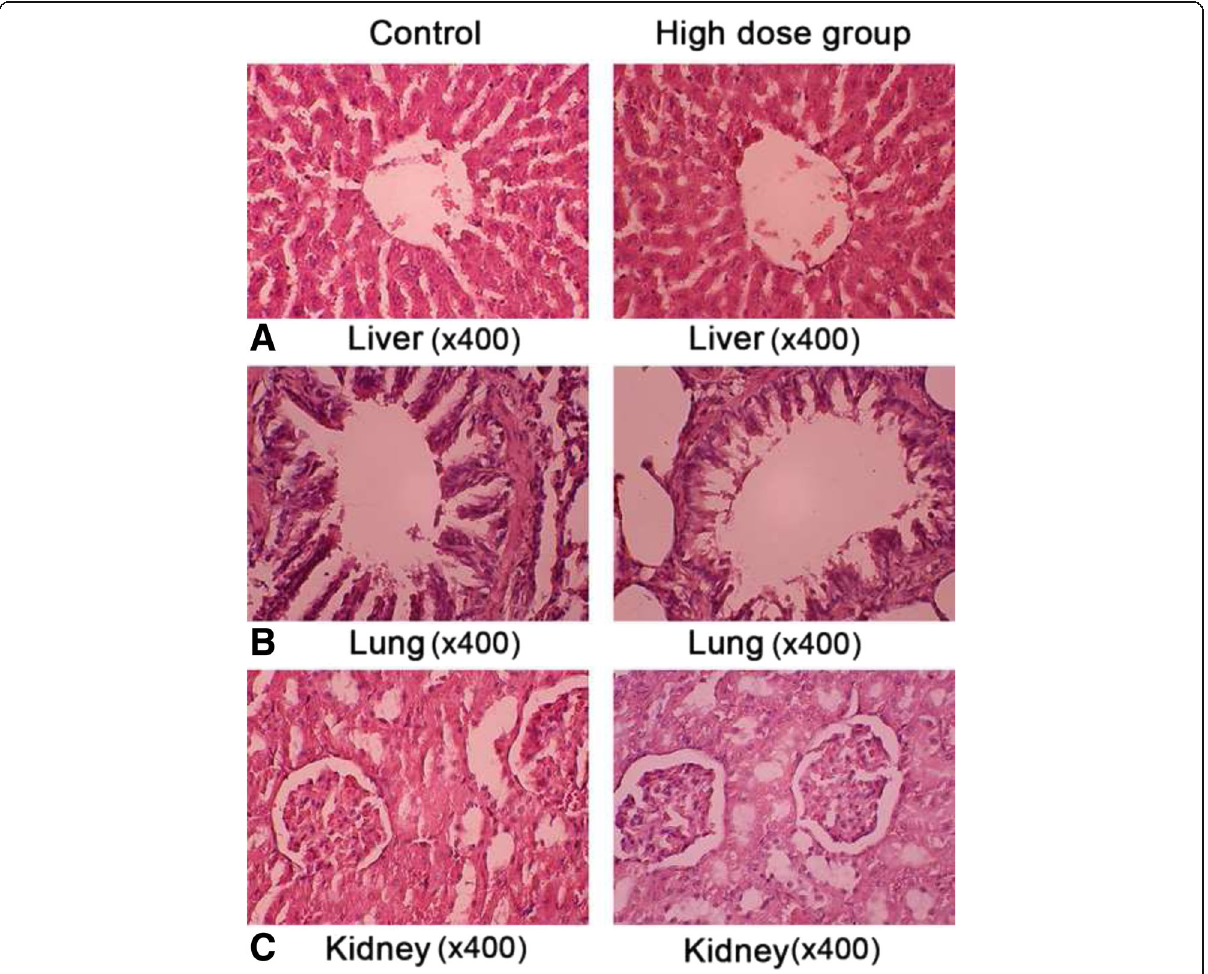
Fig. 2 JDHF treatment maintains normal structure of liver, lung, and kidney. Representative images of H&E-stained sections of liver ( a ), lung ( b ), and kidney ( c ) from Wistar rats treated with or without JDHF are shown. Images were taken at a magnification of